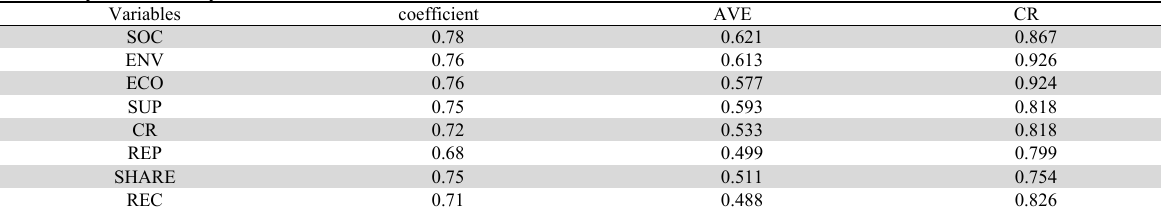
Reliability and Validity of the structure